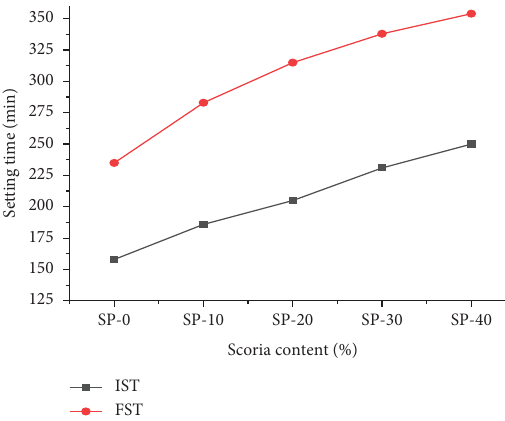
Figure 5: Graph of setting time versus scoria content.